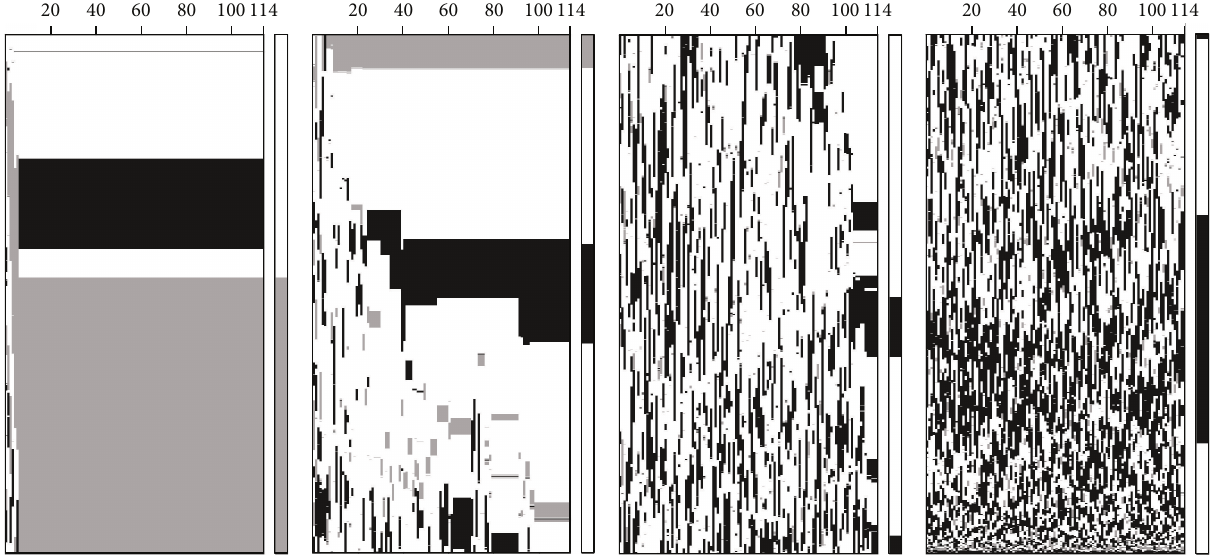
Figure 3: Experimental result of our binning method, where each row in a subdiagram represents the successive states of the corresponding cell and each column shows the cell’s state in an iteration. There are totally 5,000 rows (or cells) divided into four parts, and the 1D-CA converges after 114 iterations. There are three colors associated with three species of dataset, and the rightmost bars in the four subdiagrams are the output of our binning